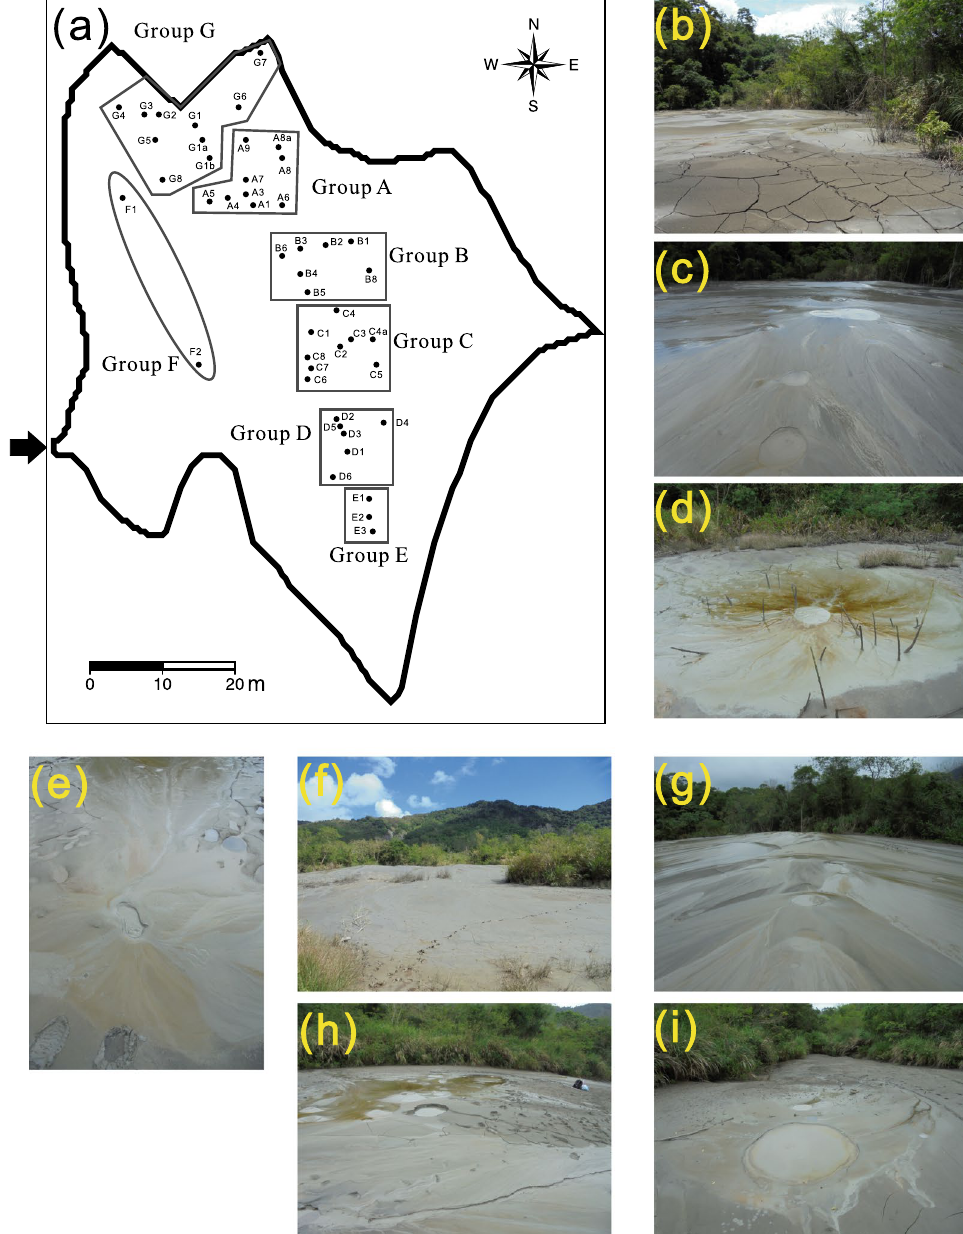
Fig. 3 a Mud covered area of MV LGH (solid line) and the location of each sampled mud pool (black dots) and the groups from A to G. Arrow indicates the entrance of the MV field. b Photograph of group G facing west taken on 2016–06‑21. c Photograph of group A facing east taken on 2015–06‑21. d Photograph of mud pool F1 taken on 2016–02‑23. e Photograph of mud pool F2 taken on 2016–03‑22. f Photograph of group B (left) and C (right) facing east from the entrance taken on 2015–11‑16. g Photograph of shield axis mud pools taken from group C facing north on 2016–05‑24. h Photograph of group D taken on 2016–02‑23. i Photograph of group E taken on